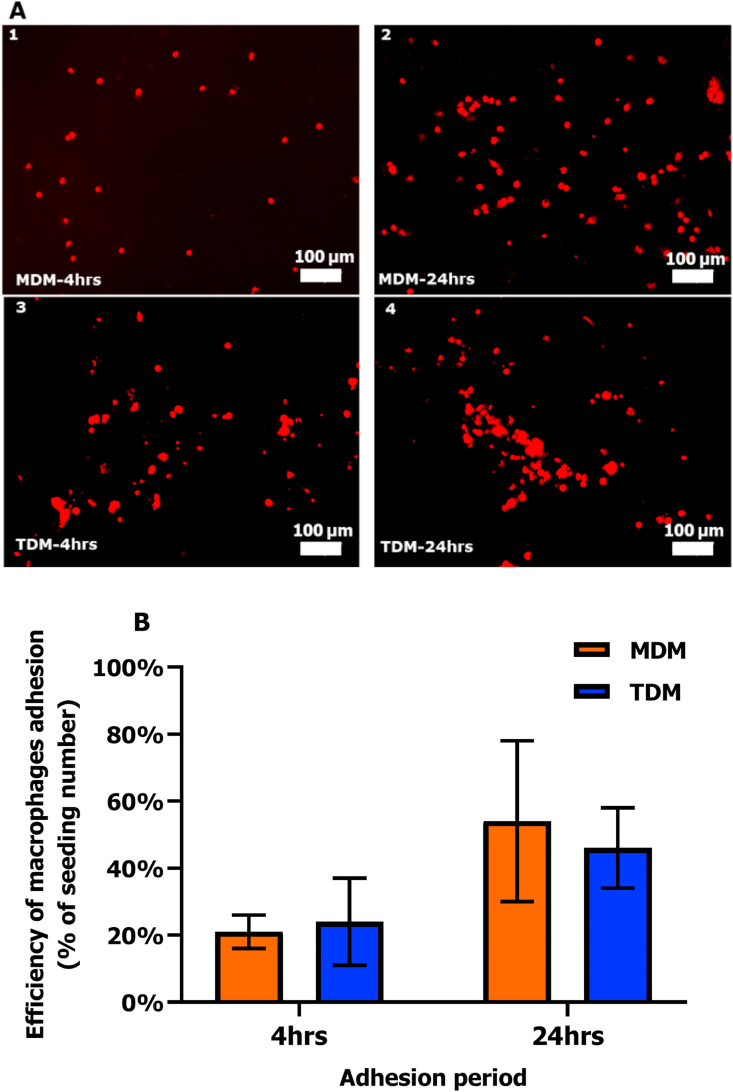
Fluorescence microscopy images (A) of MDMs and TDMs (2.0 × 104 cells/cm2) after 4 (left) and 24 h (right) adhesion onto the Calu-3 epithelial carpet and their adhesion efficiency (B). Macrophages were labelled with Vybrant DiI dye (in red, A). Scale bars in A: 100 μm. B: Error bars indicate the standard deviation of macrophages number in 4 or 6 random areas of the insert membrane. More images of MDMs and TDMs in Fig. S4. (For interpretation of the references to colour in this figure legend, the reader is referred to the Web version of this article.)